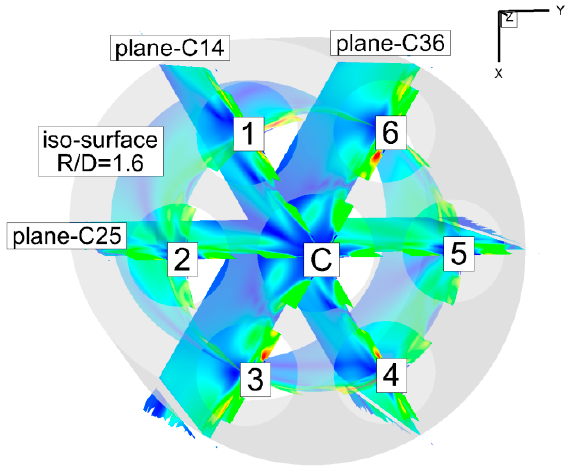
Figure 16. Relation between nozzles and selected